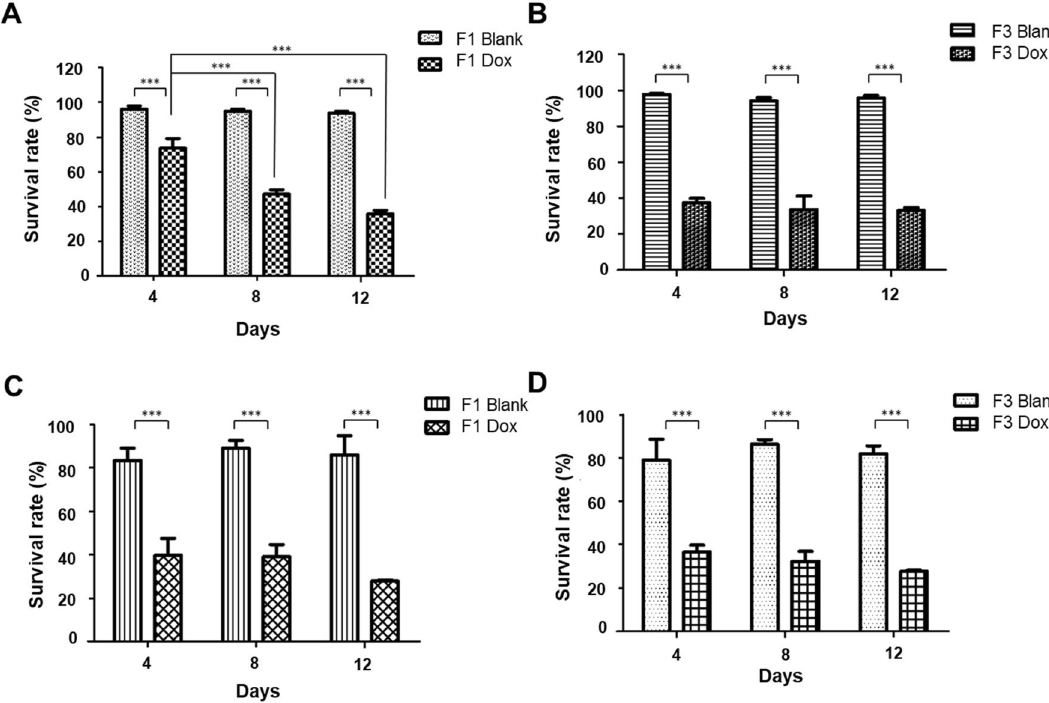
Figure 7. Sustained-release of Dox is profound in F1 compared to F3 calcium alginate microcarriers in Huh-7 and Hep-3B cells. Cells were treated with F1 and F3 calcium alginate microcarriers without (Blank) or with Dox and cell survival rates were measured with trypan blue exclusion method for 4, 8 and 12 days. ( A , B ) Huh-7 cells. ( C , D ) Hep-3B